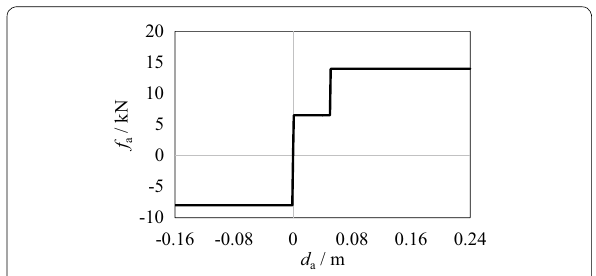
Figure 3 Force–stroke relationship of secondary strut